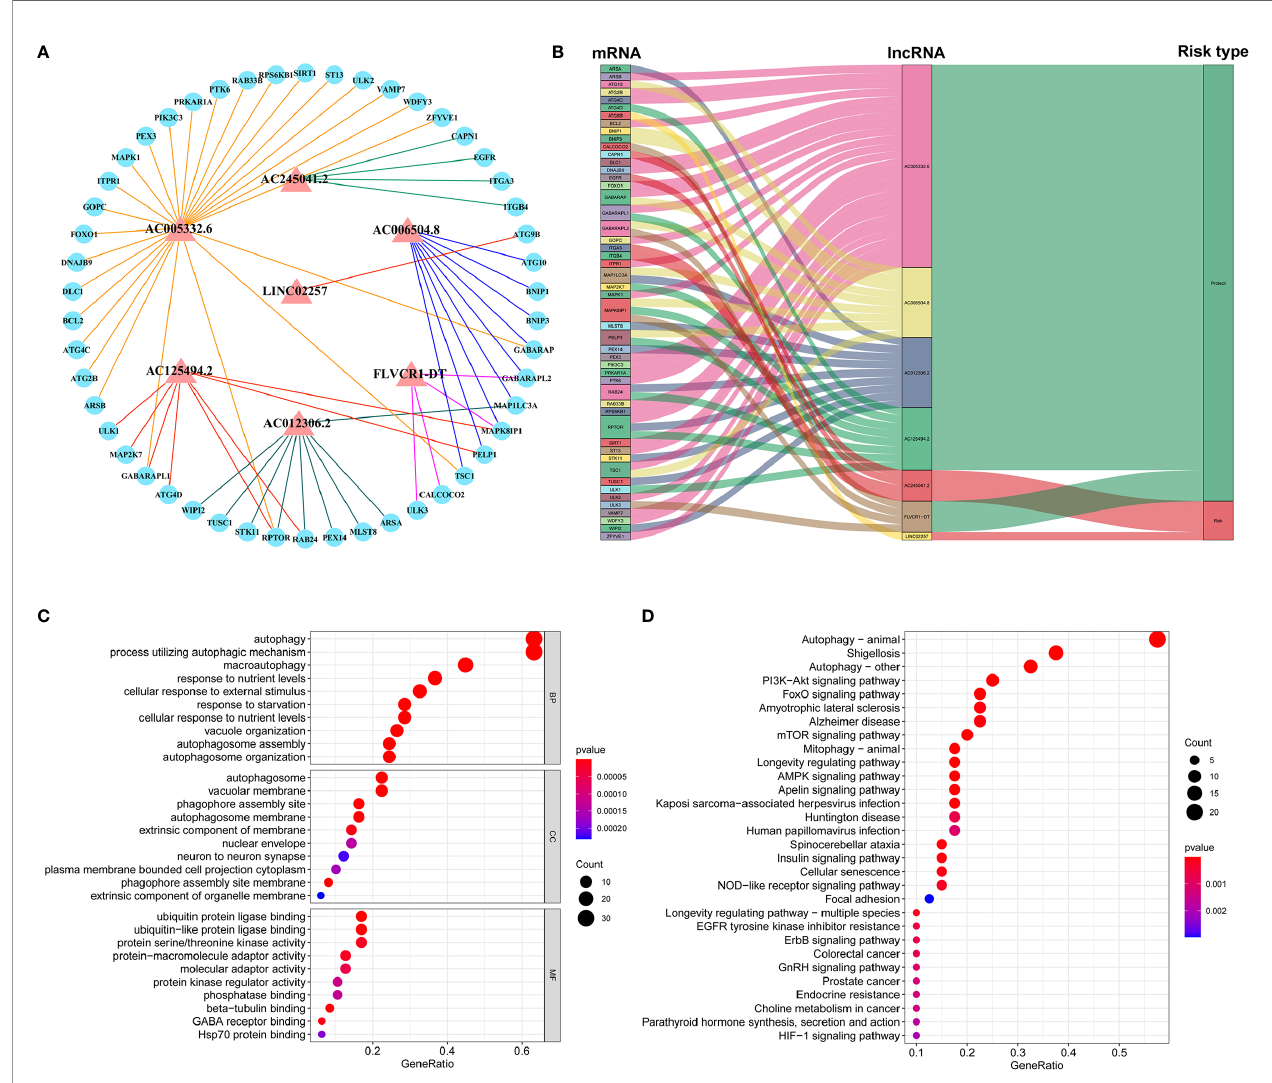
FIGURE 4 | Construction of lncRNA – mRNA co-expression network and GO and KEGG enrichment analysis. (A) The lncRNA – mRNA network between seven autophagy-associated lncRNAs and relevant mRNAs. Red triangles indicate autophagy-associated lncRNAs. Blue circles indicate mRNAs. The line represents a co- expression relationship between the lncRNA and the mRNA. (B) A Sankey diagram showed the co-occurrences of lncRNAs, mRNAs, and characters according to the risk score. (C) GO analysis of biological processes, cell components, and molecular functions based on the co-expressed mRNAs. (D) KEGG analysis showed the signi fi cantly enriched pathways based on the co-expressed